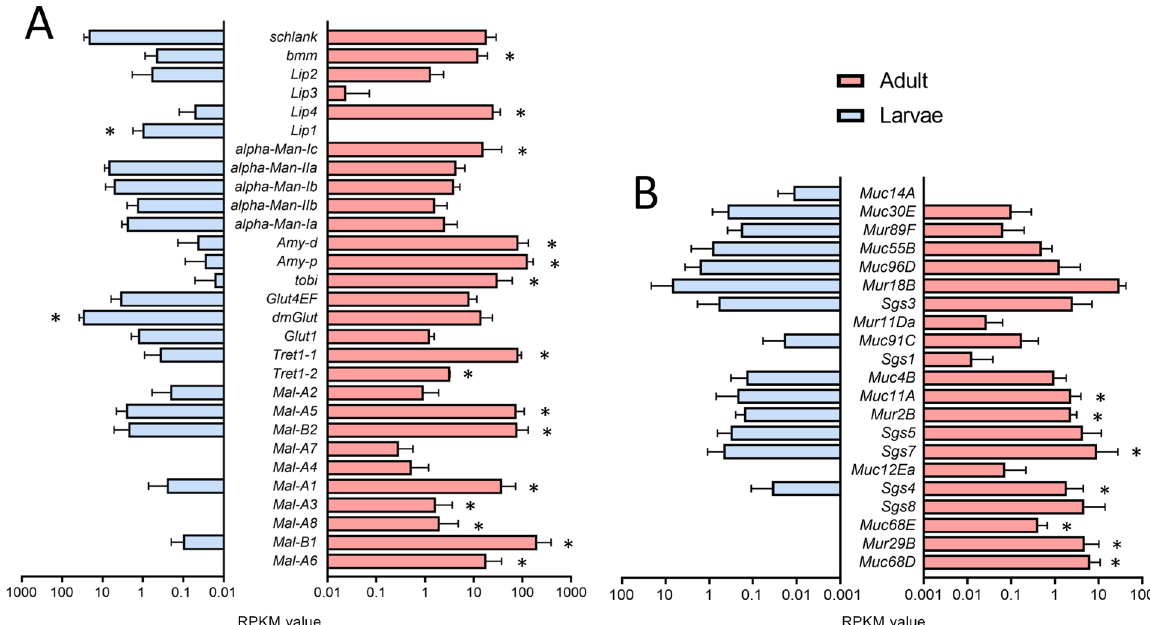
Figure 5. Expression of genes associated with metabolism and production of mucin-like products. ( A , B ) Bar charts showing the RPKM values compared between larval (blue) and adult trachea (red). Expression levels of genes that are associated with lipid metabolism ( A ) and Muc , Mur, and Sgs genes ( B ) that are differentially transcribed between larvae (blue) and adults (red). Asterisks indicate a differential gene expression based on the RNA-Seq analysis. Bars show mean with SD, n = 4.